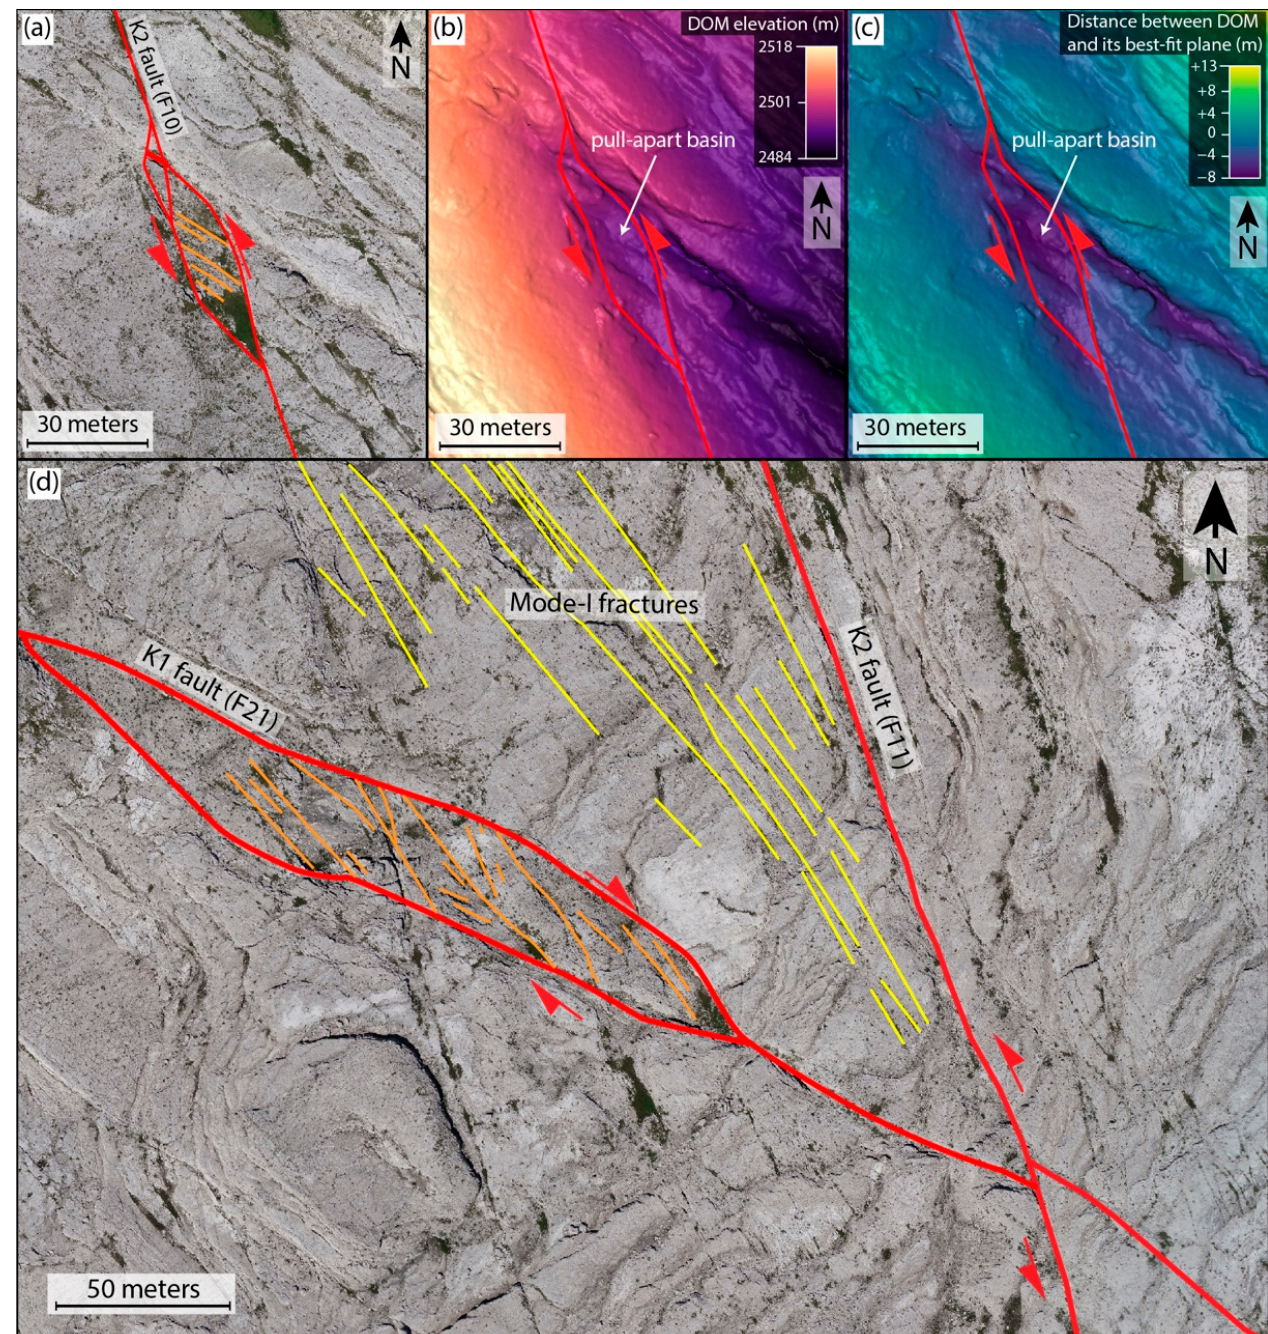
Figure 15. Examples of strike ‐ slip structures visible at the top of the platform. ( a ) DOM top view of a releasing stepover structure that forms a sort of small pull ‐ apart basin along a K2 fault. Its presence is enhanced by ( b ) the DOM elevation and ( c ) the DOM distance from the ‘local’ plane that best fits the surface of the top plateau. ( d ) Releasing stepover on a K1 fault (F11) and mode ‐ I (tensional) fractures oriented parallel to the bisector of the conjugate strike ‐ slip faults. The inferred kinematics is dextral for the K1 and sinistral for the K2 faults,